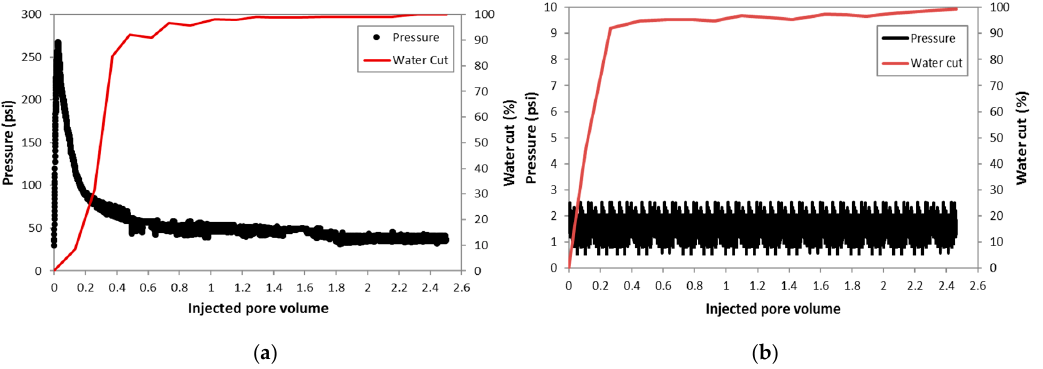
Figure 6. Pressure drop and water cut during water flooding in homogeneous ( a ) and fractured ( b ) rock samples.